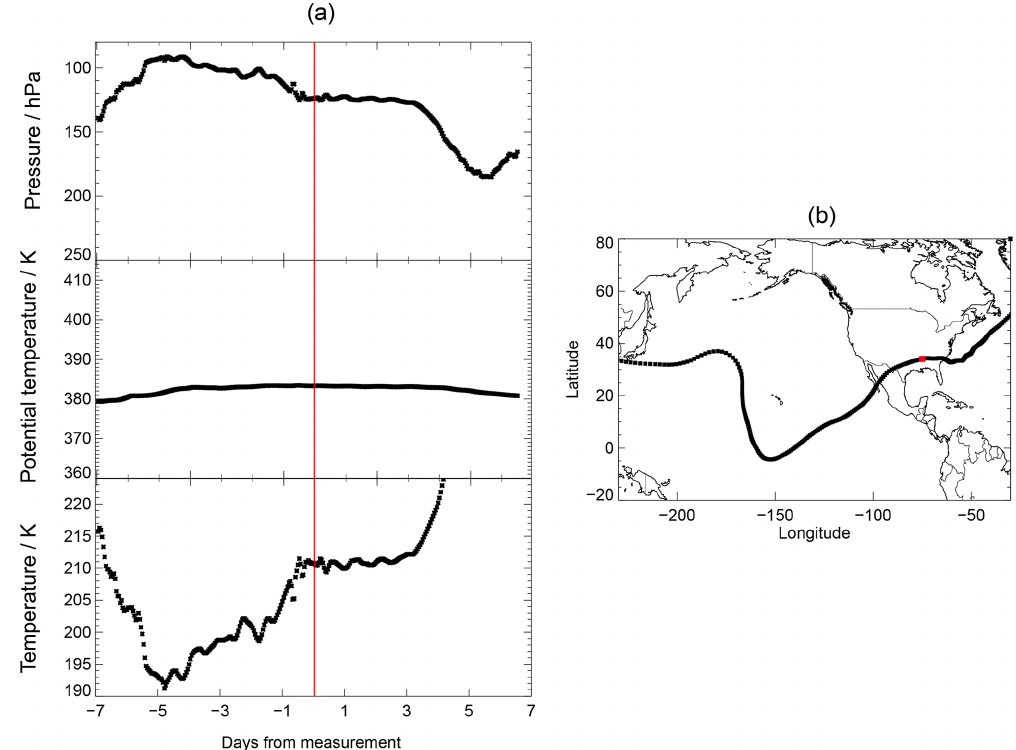
Figure B1. Pressure, potential temperature, temperature and location of the selected trajectory calculated based on measurements with enhanced water vapour during the MACPEX aircraft campaign. The red line (a) marks the time of measurement and the red square (b) mark the location of the measurement. Since the tropopause is very low, it is not plotted here. In (b) , the beginning of the trajectory (4 April 2011) is at the left edge of the panel. In the bottom panel of (a) , the MACPEX trajectory consists of single squares due to a faster movement of the air parcel in that